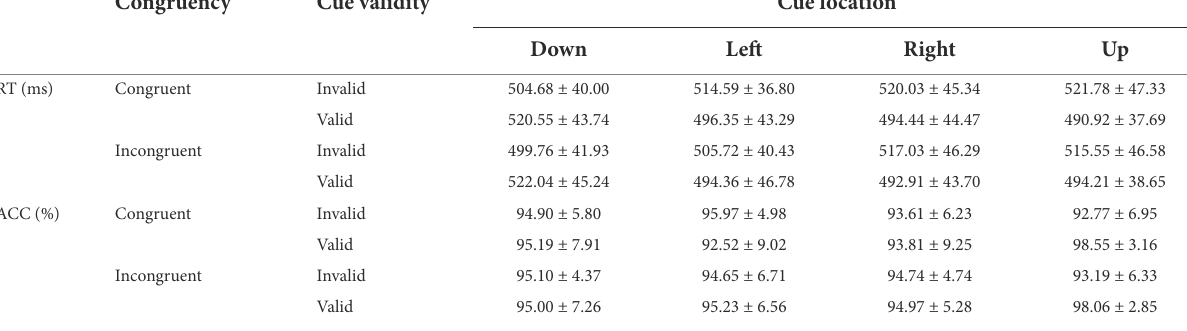
TABLE 2 The average response times and accuracy rates under the combinations of cue validity, cue-target semantic congruency and cue location in Experiment 1 (M ±